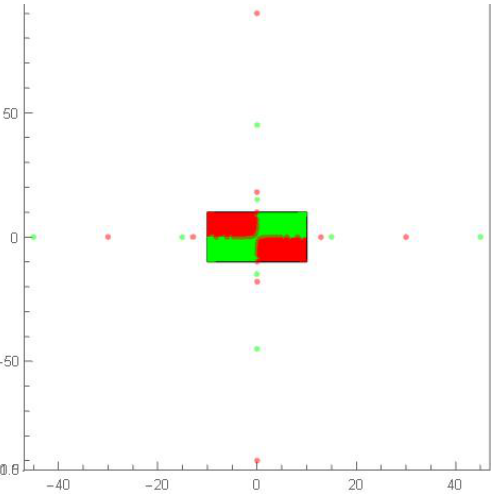
Figure 9. Helstrom method with highlighted points classified